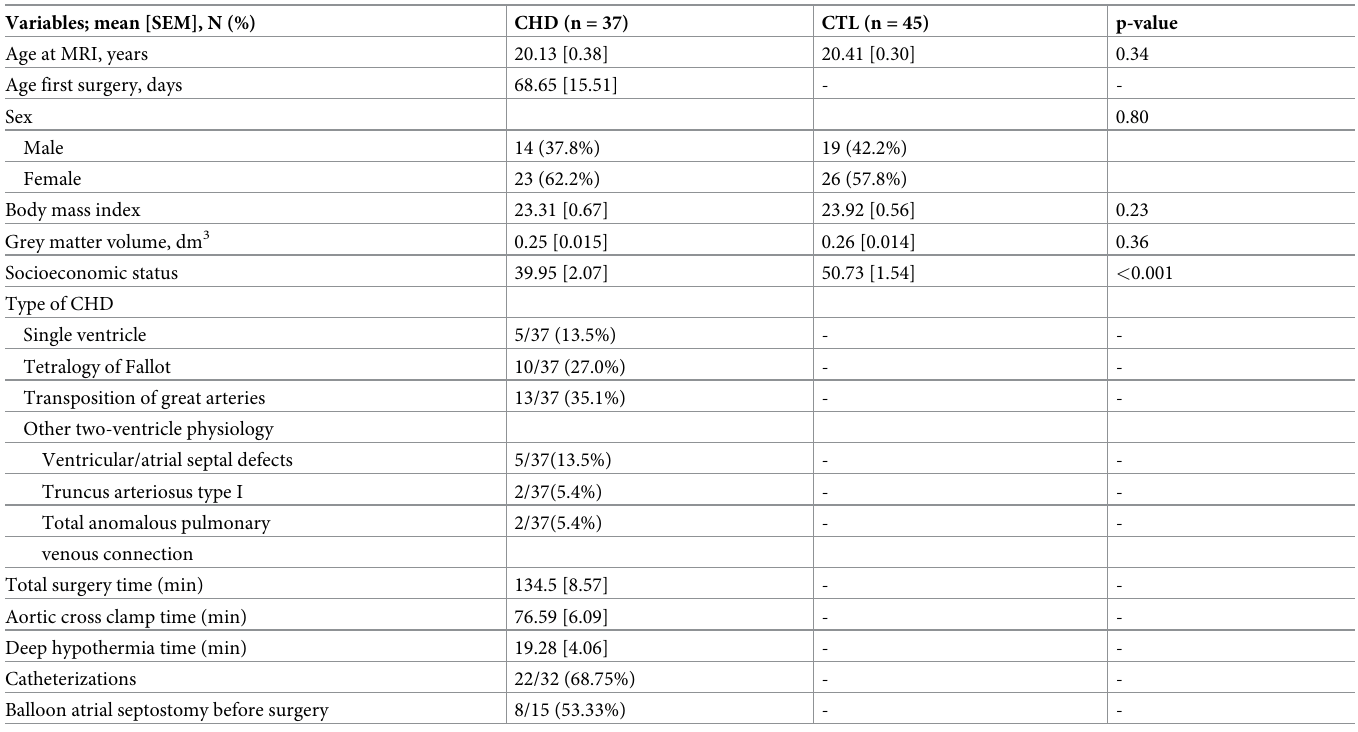
Table 1. Participants’ characteristics.